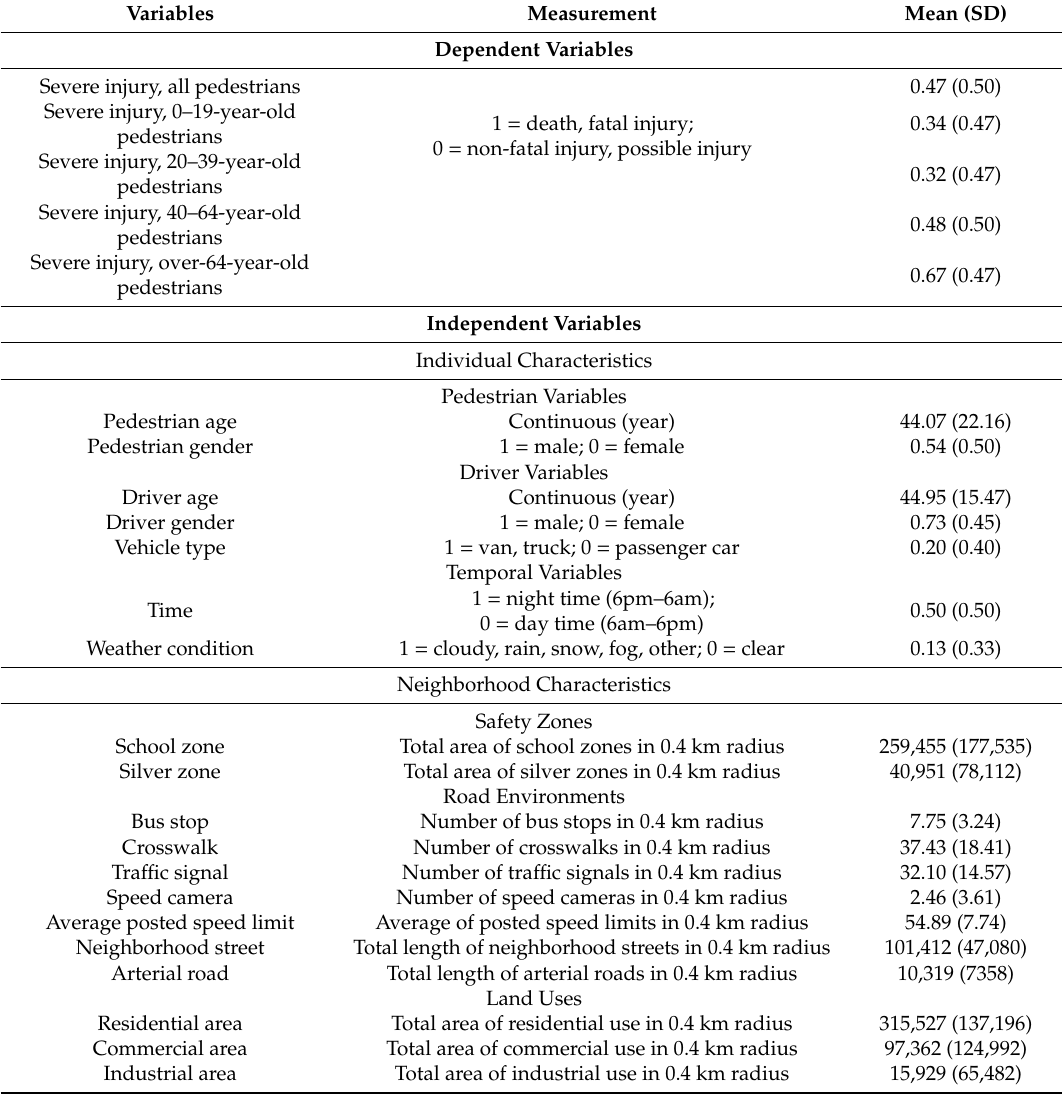
Table 1. Construction of the variables used in the analysis and basic